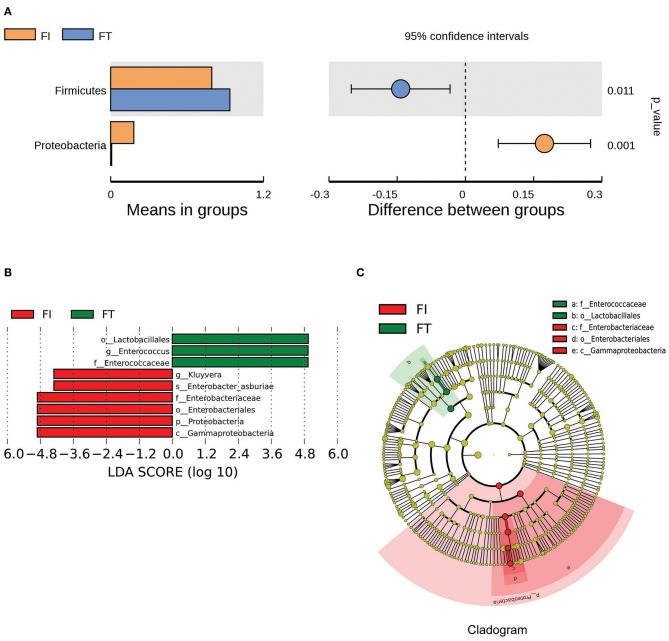
The differential microbes between FI and FT groups. (A) Analysis of difference in microbes between two groups using t-test. (B) LDA value distribution. (C) Evolutionary cladistics (phylogenetic distribution).